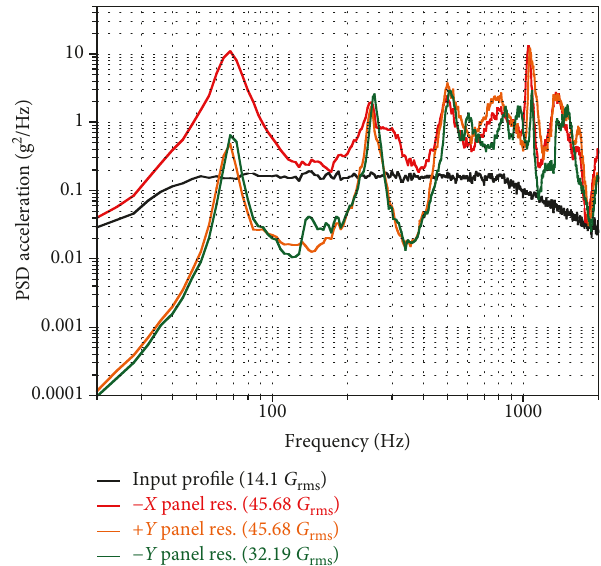
Figure 12: Random vibration test results of the mechanism along the x -axis excitation.